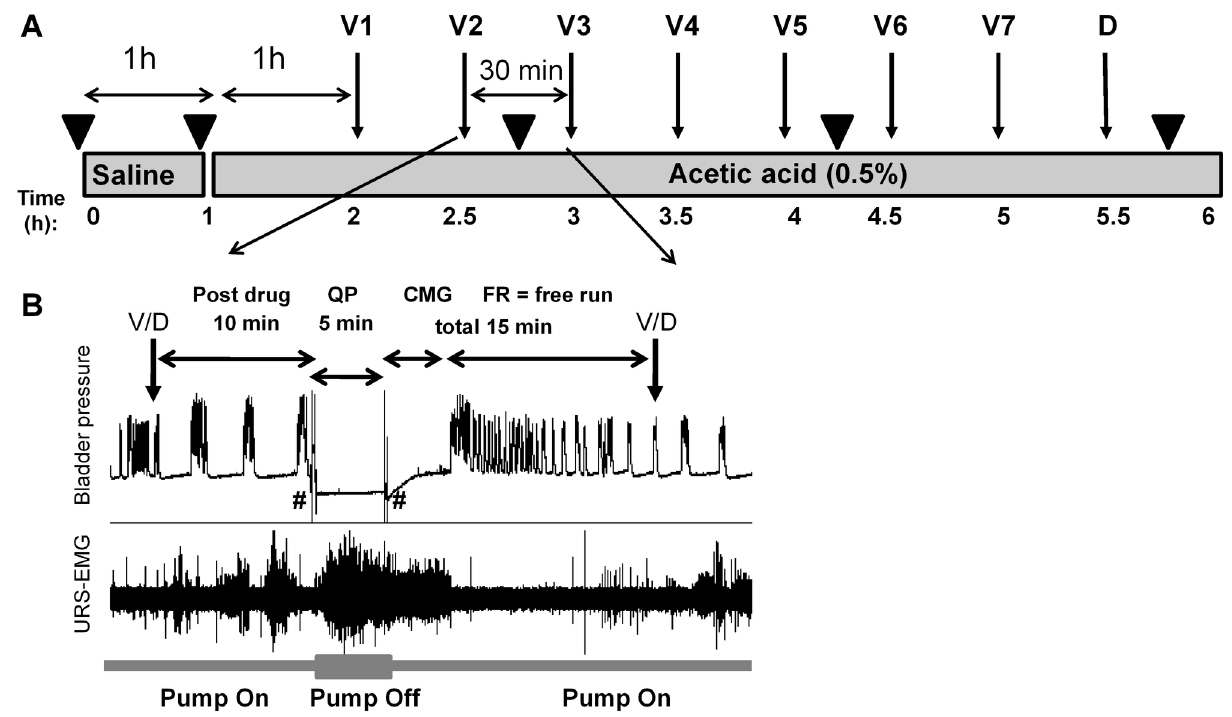
Figure 1. Experimental protocol. A. Schematic of the protocol design. The bladder was infused with saline for 1h, followed by saline with 0.5% acetic acid for the remaining of the experiment. V1-V7 indicate vehicle (saline 0.5mg/kg) given i.v. every 30 minutes. D indicates duloxetine, 1mg/kg i.v. Numbers under grey boxes show time in hours from the beginning of the recordings. B. Inset illustrates the 30 minute four-step protocol, which is repeated throughout the experiment following each vehicle or drug (V/D) delivery. The steps are: post drug (PD), quiet period (QP), cystometrogram (CMG) and free run cystometry (FR). PD is a period of 10 minutes of continuous cystometry immediately following drug injection. After this period, the infusion pump is stopped and the bladder is drained and allowed to rest for 5 minutes, which defines the QP. At the end of the QP the bladder is drained again, the infusion pump turned on and a CMG is started. This period is followed by continuous cystometry (FR). CMG and FR periods total 15